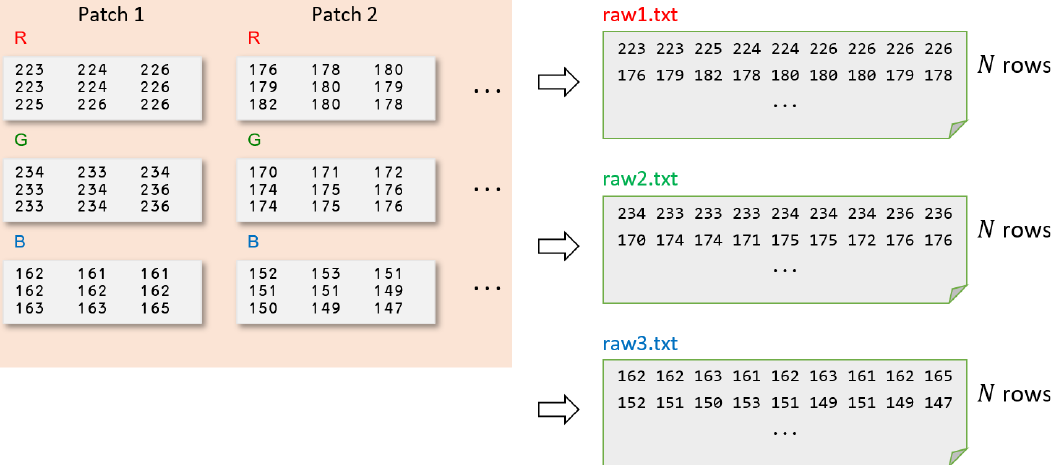
Figure 4. Demo example depicting ( left ) the first two (out of N ) patches with dimensions of 3 × 3 of an example color RGB image and ( right ) the first two lines of the corresponding raw text files. Each text file line contains 3 × 3 = 9 values, and there are as many lines as the number ( N ) of patches.